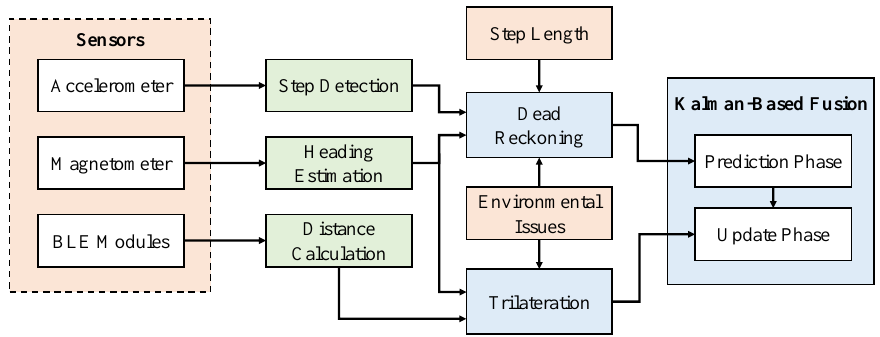
Figure 9. Architecture of the proposed Kalman-based fusion